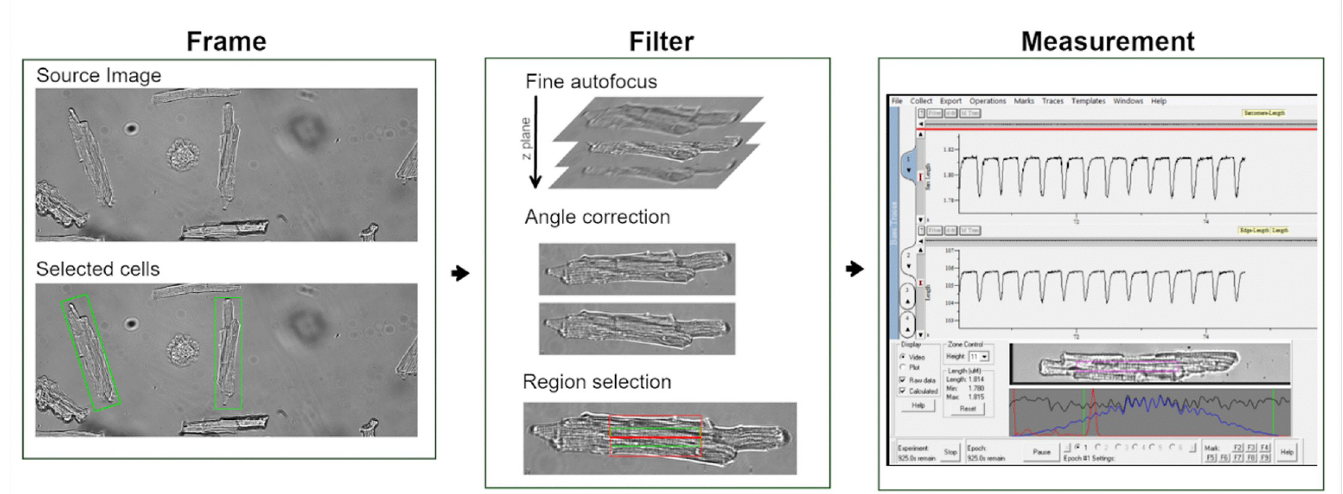
Fig 2. Structure of automatic cell finding scheme. Frame layer finds valid cells in the FOV. Filter layer finds the best subregion for sarcomere length measurement. It includes three main steps: fine autofocus, angle correction and region selection. Once the subregion is found, contractility measurement is conducted in this region, top trace shows sarcomere length, bottom trace shows cell length trace.